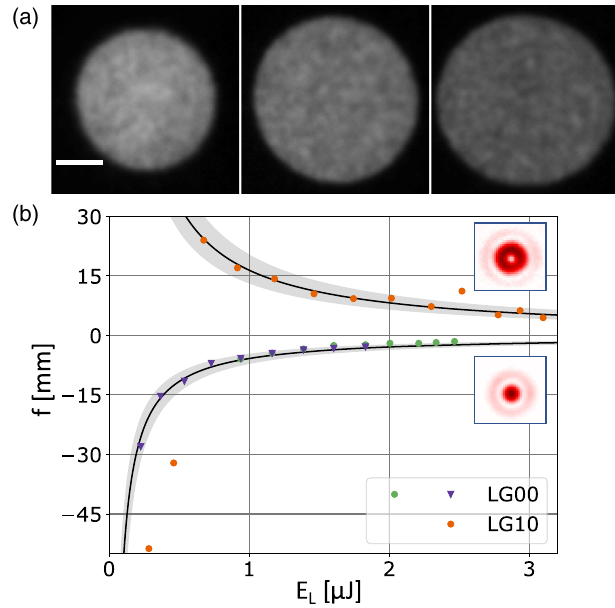
FIG. 3. Lensing using ponderomotive potentials. (a) Detected electron distribution with concave (left, LG00), no (center), and convex (right, LG10) ponderomotive lens (scale bar 1 mm). (b) Focal length as a function of the laser pulse energy for LG00 (green and violet) and LG10 (orange) modes. The inset shows the respective light intensity distributions, measured in a plane conjugate to the interaction plane.